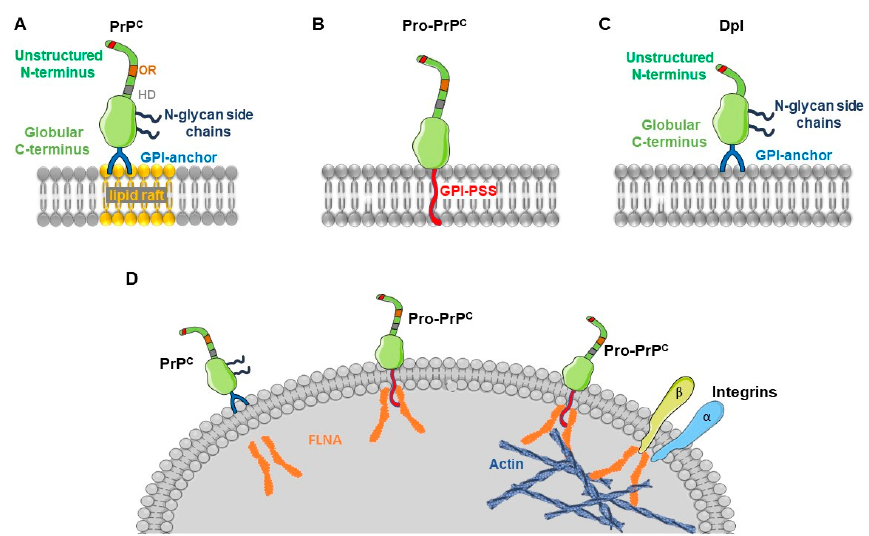
Figure 2. Structural features, cell membrane anchorage and interactions with schematic representation of PrP C , Pro-PrP, and Dpl. ( A ) Cellular prion protein (PrP C ) contains a N-terminal octapeptide repeat domain (OR), a highly conserved hydrophobic signal domain (HD), and a C-terminal hydrophobic region comprising a glycosylphosphatidyl-inositol (GPI) which anchors to the plasma membrane outer face in the lipid raft; ( B ) Pro-prion (Pro-PrP), lacks the N-terminal signal peptide, N-glycan chains and GPI, while it retains the C-terminal GPI anchor peptide signal sequence (GPI-PSS). As a result, Pro-PrP is inserted into the phospholipid bilayer by GPI-PSS rich in hydrophobic amino acids; ( C ) Doppel (Dpl), an N-terminally truncated PrP C protein lacking the octamer repeats. ( D ) Di ff erently form PrP C , Pro-PrP interacts with filamin A (FLNA) a cytoplasmic protein involved in actin organization. FLNA acts as cytolinker, which allows the binding of cell surface receptors such as integrins, to F-actin filaments, and forming an actin network responsible for the maintenance of membrane integrity, cell-cell, and cell-matrix